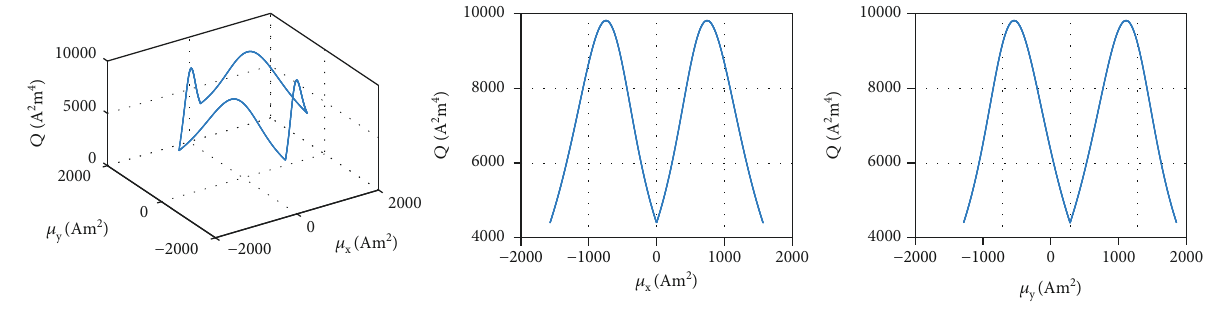
Figure 10: The desired force is [0, 0.5N, 0] T